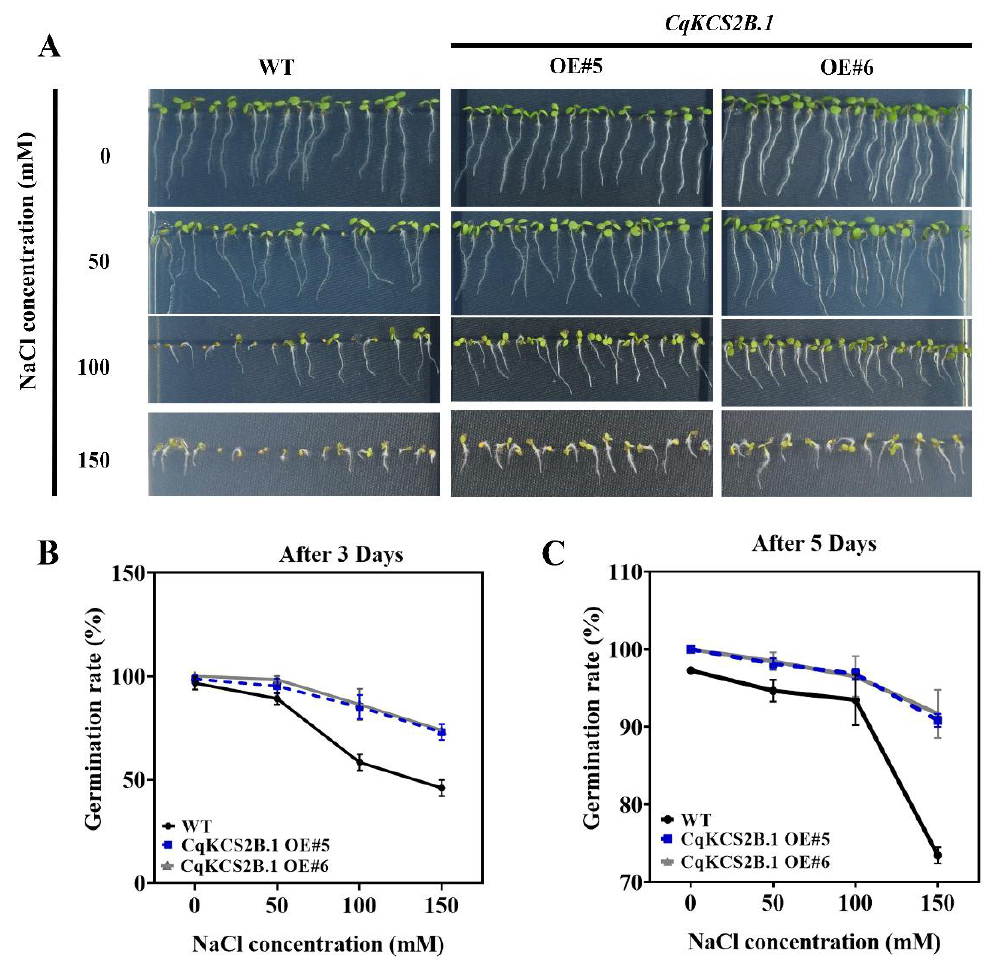
Figure 7. Seeds’ germination rates of WT and CqKCS2B.1 OE lines under varying degrees of salt stress. ( A ) Germinating seeds of WT (Col-0), CqKCS2B.1 OE#5, and OE#6 at 5 d after exposure to light after treatment with NaCl at t 0 to 150 mM. ( B ) Seed germination percentage on medium containing 0, 50, 100, and 150 mM NaCl treatment after 3 d in the light. ( C ) Seed germination percentage on medium containing 0, 50, 100, and 150 mM NaCl at 5 th day in the light. Each value represents the mean ± SD of 50 independent measurements. Statistical significance was evaluated by ANOVA.